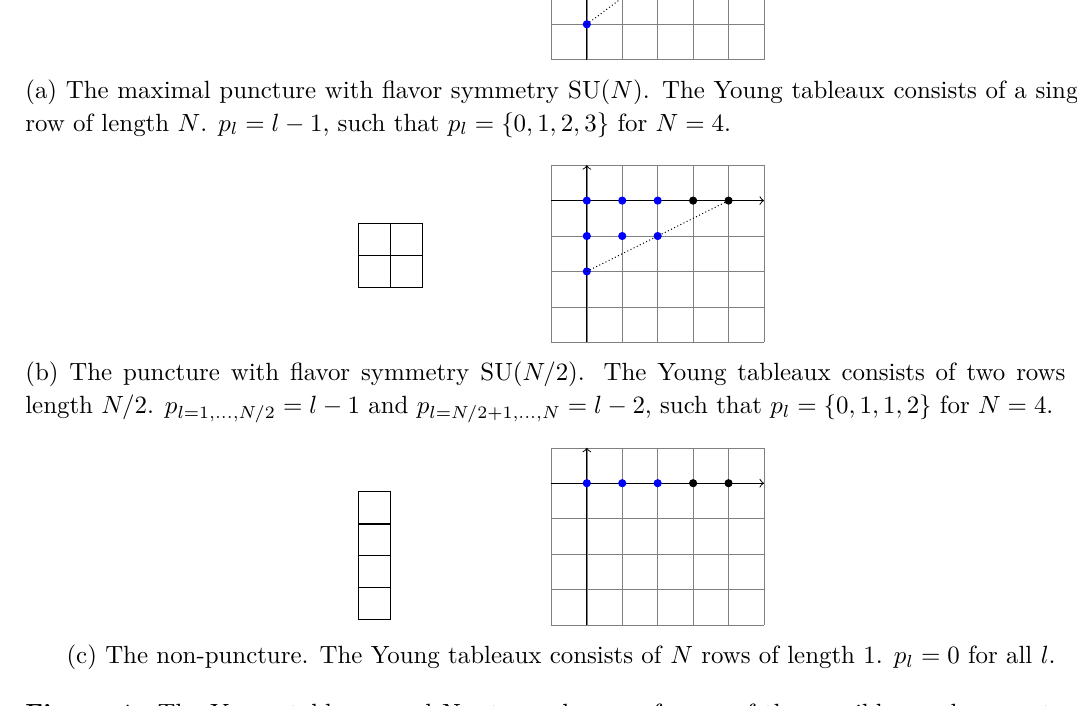
Figure 4. The Young tableaux and Newton polygons of some of the possible regular punctures for N = 4 . The black dots correspond to the x N − 1 line and the leading x N term, which have no corresponding deformation parameters.